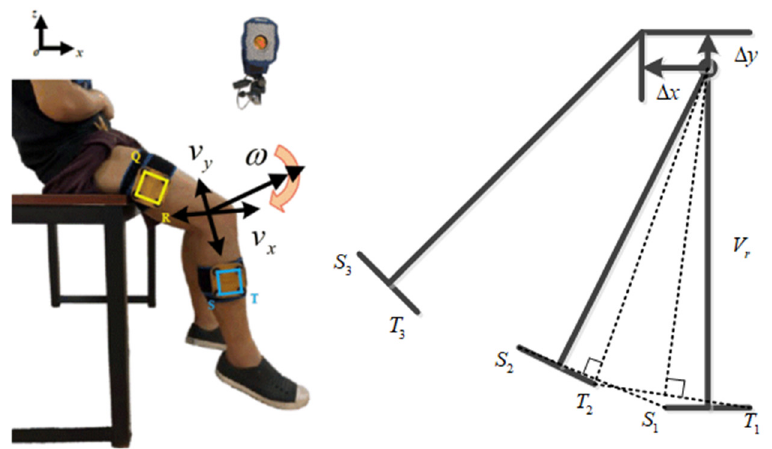
Figure 2. Measurement of leg translation. Table 1. Height and weight of